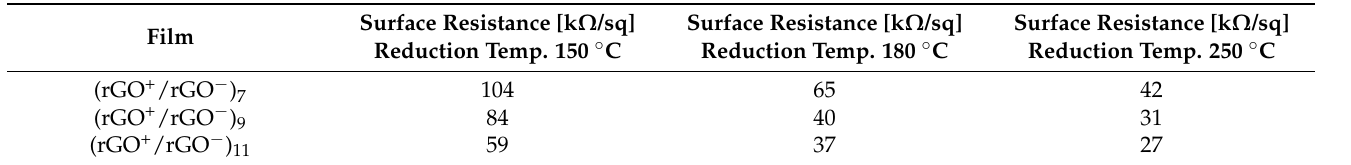
Table 1. Summary of the results of the surface resistance values for films (rGO + /rGO − ) n depending on the number of deposition cycles and the reduction temperature on quartz plates.